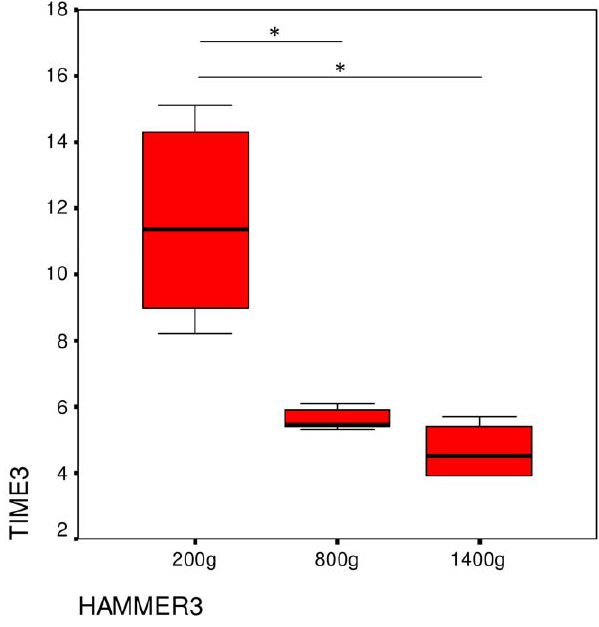
Figure 8. Median time needed to crack open a nut as a function of hammer weight in Experiment